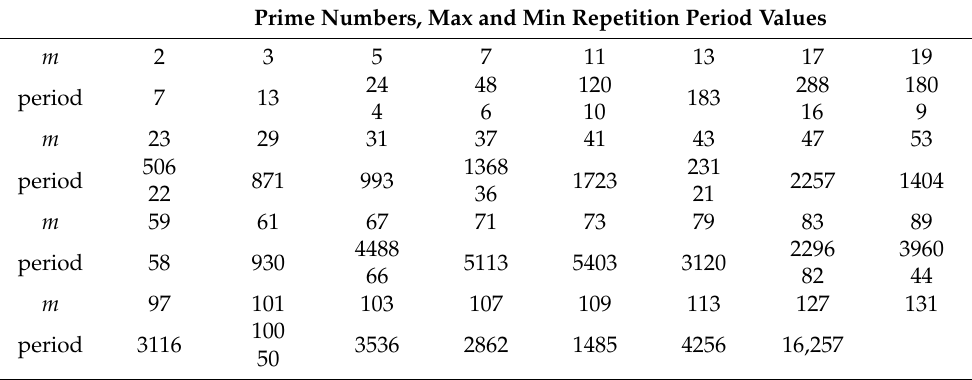
Table 1. The dependence of the repetition periods of the new AFG output sequence for some m values on the whole set of possible X (0) values. Prime Numbers, Max and Min Repetition Period Values